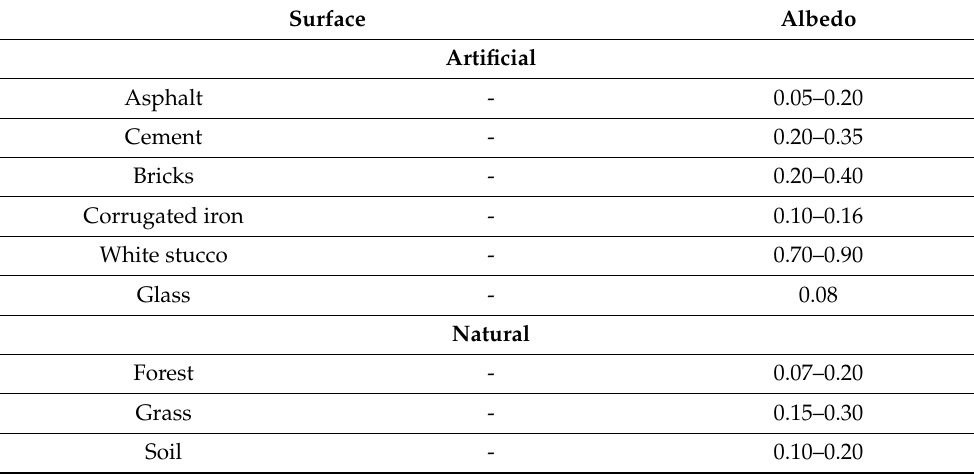
Table 8. The albedo of typical natural and artificial materials